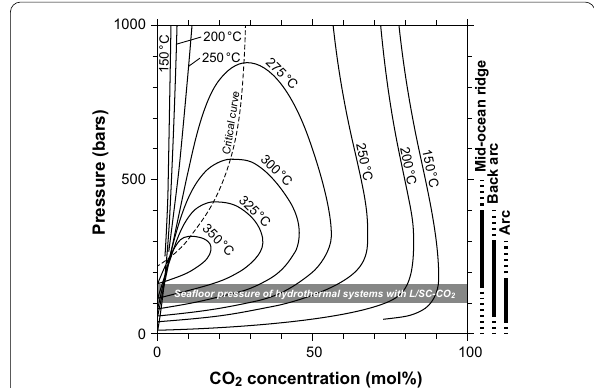
Fig. 1 Isotherm diagram of fluid compositions in the CO 2 –H 2 O system (modified from Takenouchi and Kennedy 1964), on which the seafloor pressure of hydrothermal systems hosting a L/SC-CO 2 pool projected. The ranges of seafloor pressures of hydrothermal systems at mid-ocean ridges, back arcs and arcs are summarized from the InterRidge Vents Database (https:// vents- data. inter ridge.